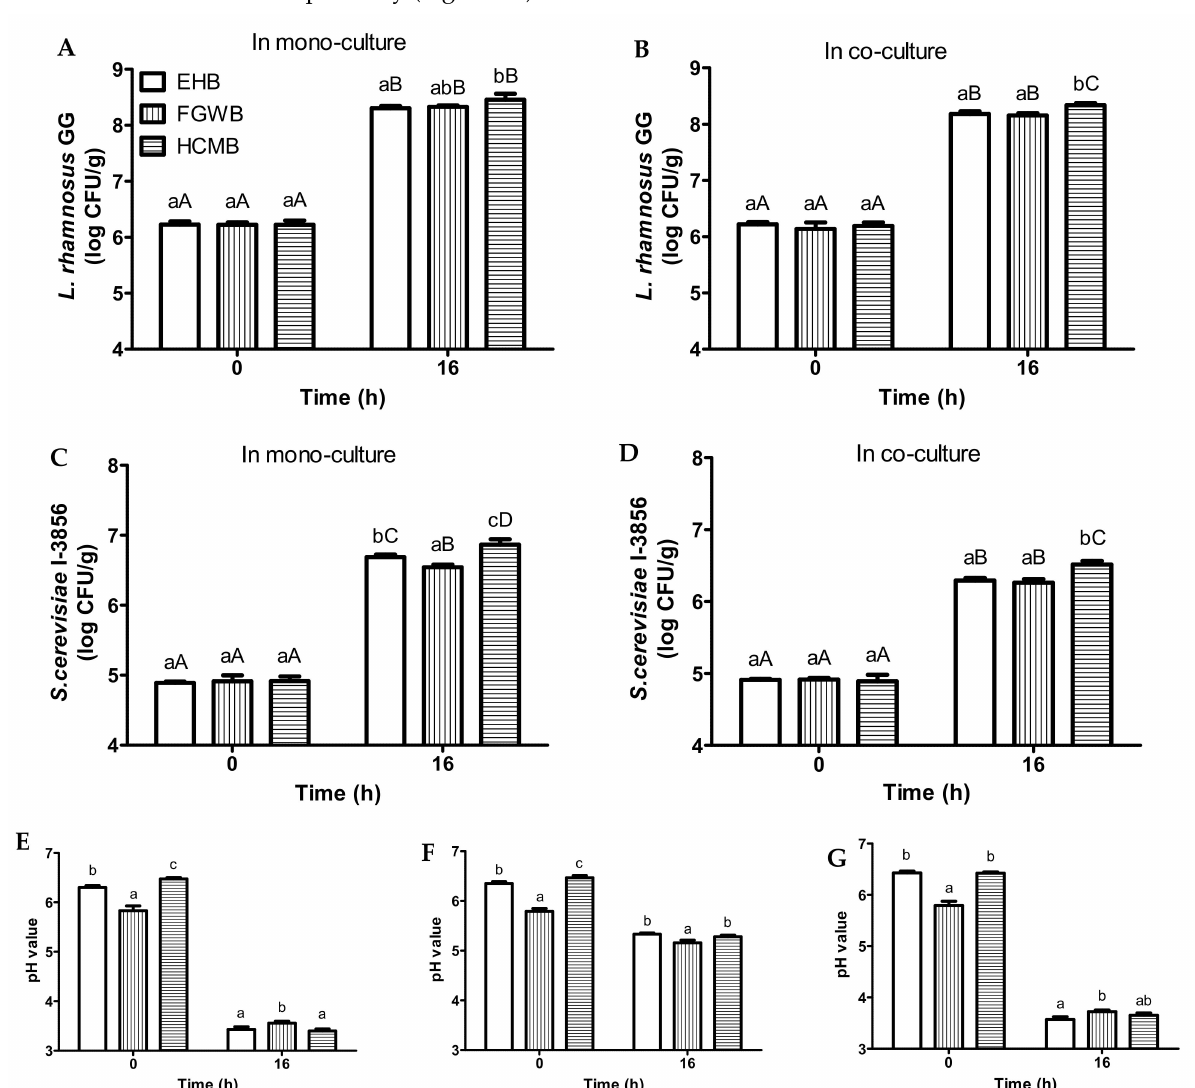
Figure 3. Changes in viable L. rhamnosus GG cell counts in monoculture ( A ) and co-culture ( B ), S. cerevisiae CNCM I-3856 cell counts in monoculture ( C ) and co-culture ( D ). Changes in pH during 37 ◦ C incubation for bread slurries inoculated with L. rhamnosus GG only ( E ), S. cerevisiae CNCM I-3856 only ( F ), and L. rhamnosus GG + S. cerevisiae CNCM I-3856 ( G ) in samples made from 5.0% total solids of enriched white bread (EHB), fine grain wholemeal bread (FGWB), and high calcium milk bread (HCMB). Mean values at the same time point with different lower case letters are significantly different ( p < 0.05). Mean values at the different time points with different upper case letters are significantly different ( p <